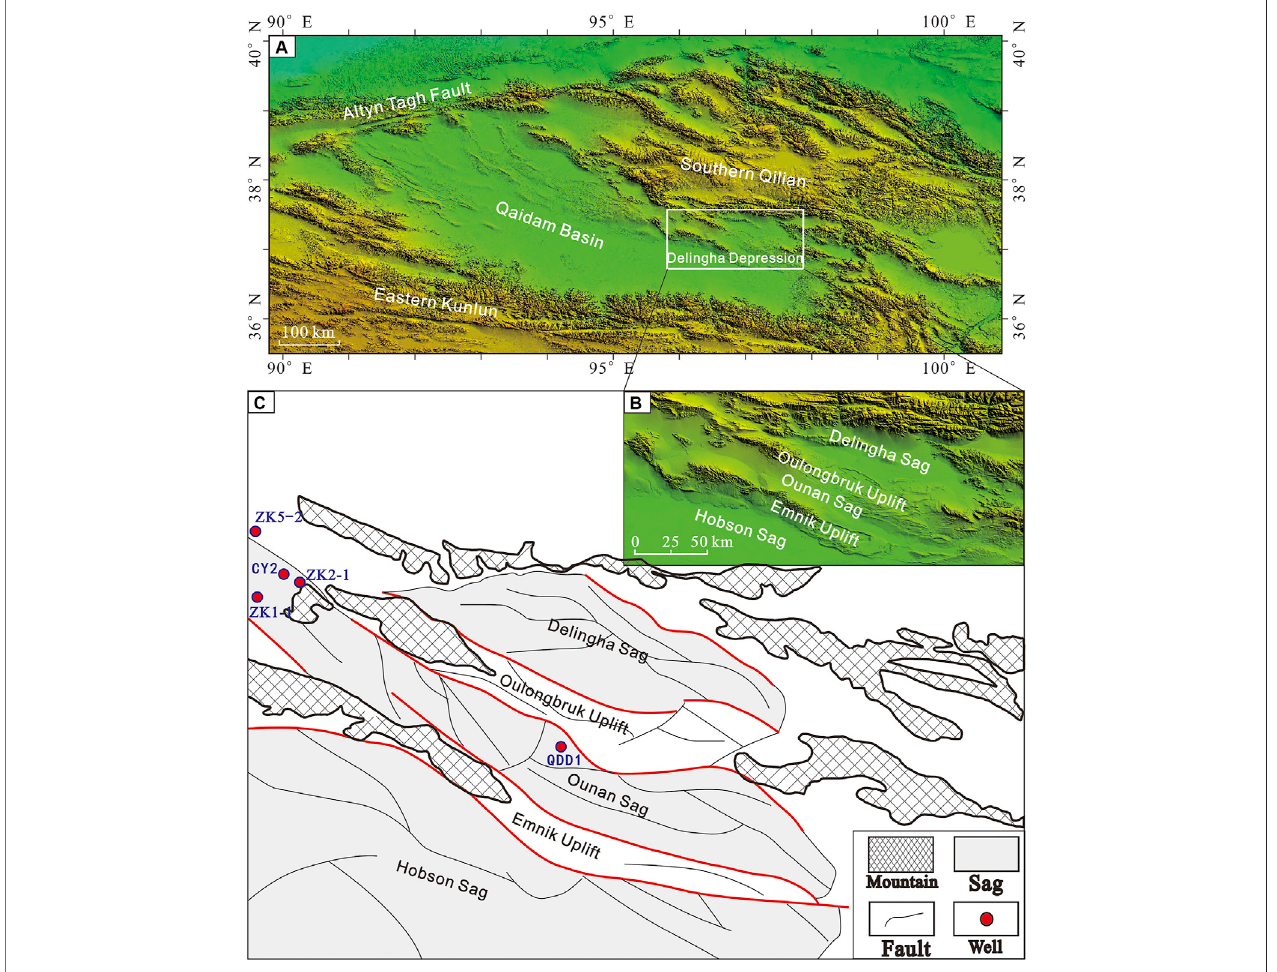
FIGURE1| DEMpresentationofthegeomorphologyoftheQaidamBasinanditssurroundingmountains (A,B) andoutlinediagramofstructureunitsattheEastern Qaidam Basin (C) .